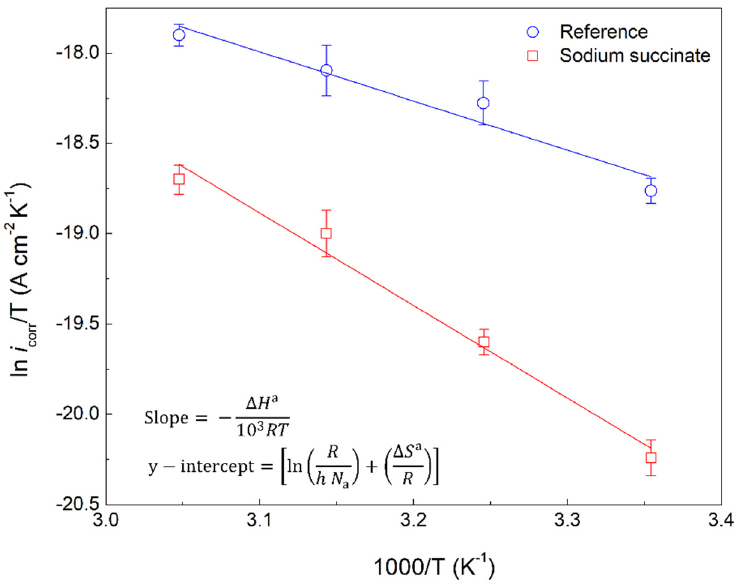
Figure 9. Transition state plot of carbon steel rebars in the presence and absence of 0.6 M sodium succinate in 0.6 Cl − SCPS.